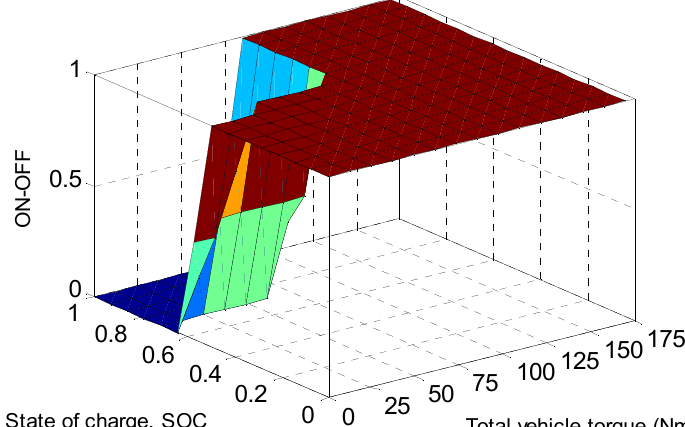
Figure 6. Surface plot for the FLC variables: Effect of SOC and vehicle driving torque on the ICE